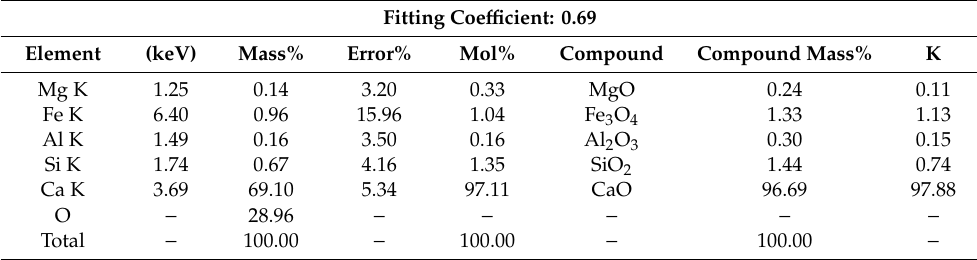
Table 6. Identified elements in Ofunato Ca(OH) 2 (black particles) after a 1st hydration in the TGA-51 system and decarbonization in a muffle furnace (measured by Energy Dispersive X-ray Spectroscopy). Fitting Coefficient: 0.69 Element (keV) Mass% Error% Mol%